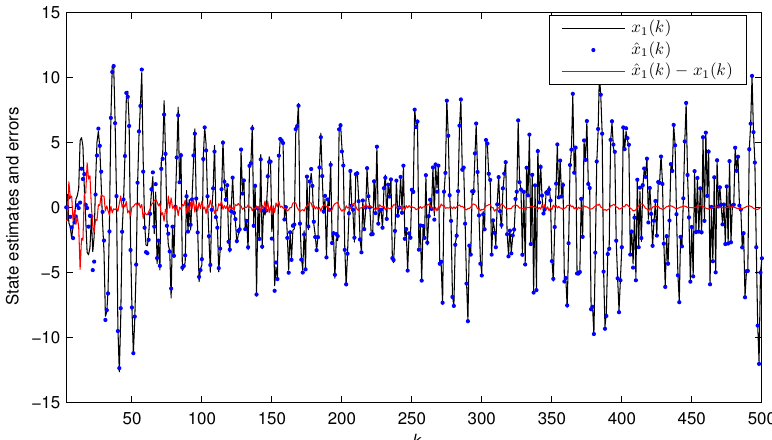
Figure 9. The true state x 1 ( k ) and the estimated state ˆ x 1 ( k ) versus k for Example 2 ( δ = 0.25).